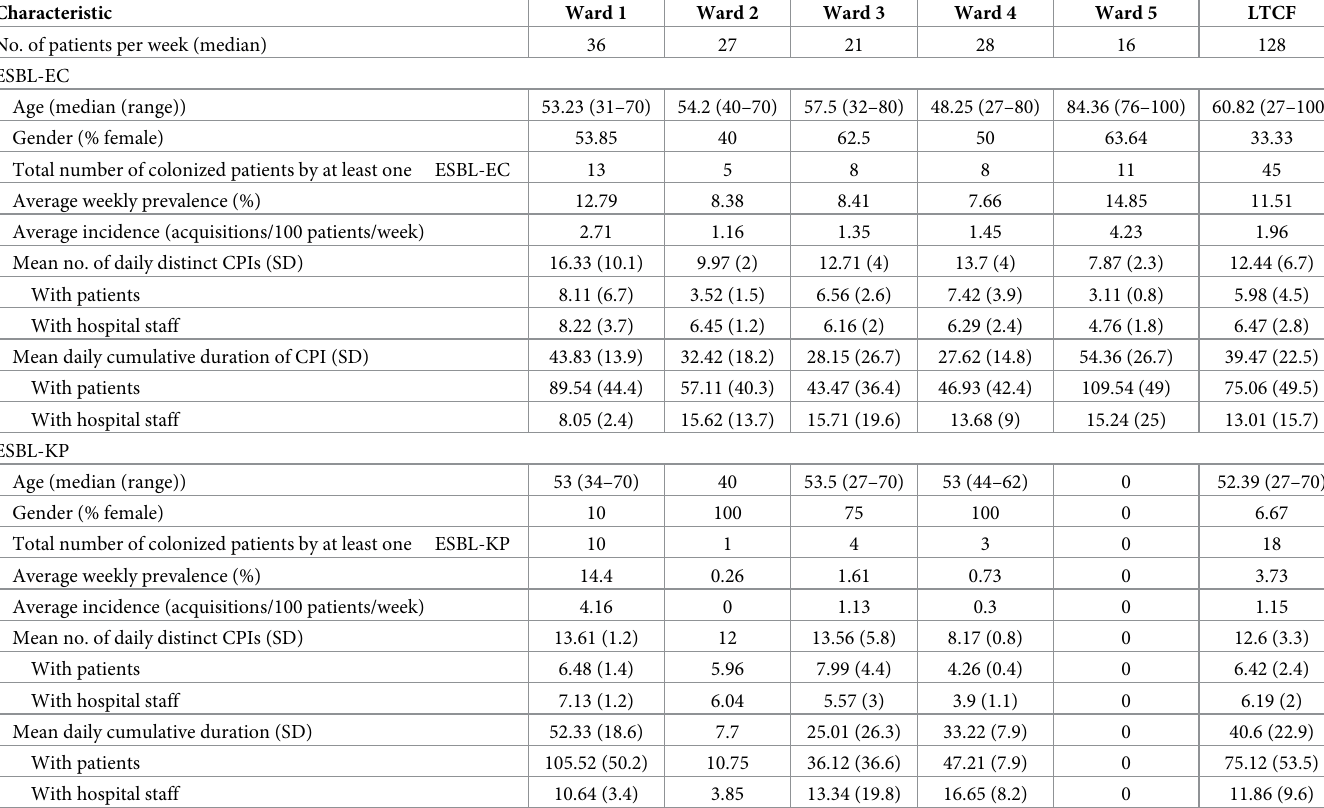
Table 1. Characteristics of the extended-spectrum β -lactamase ESBL-producing E . coli (ESBL-EC)- and K . pneumoniae (ESBL-KP)-carrier population. Details about colonized patients, ward prevalence, incidence and CPIs description of colonized patients are summarized